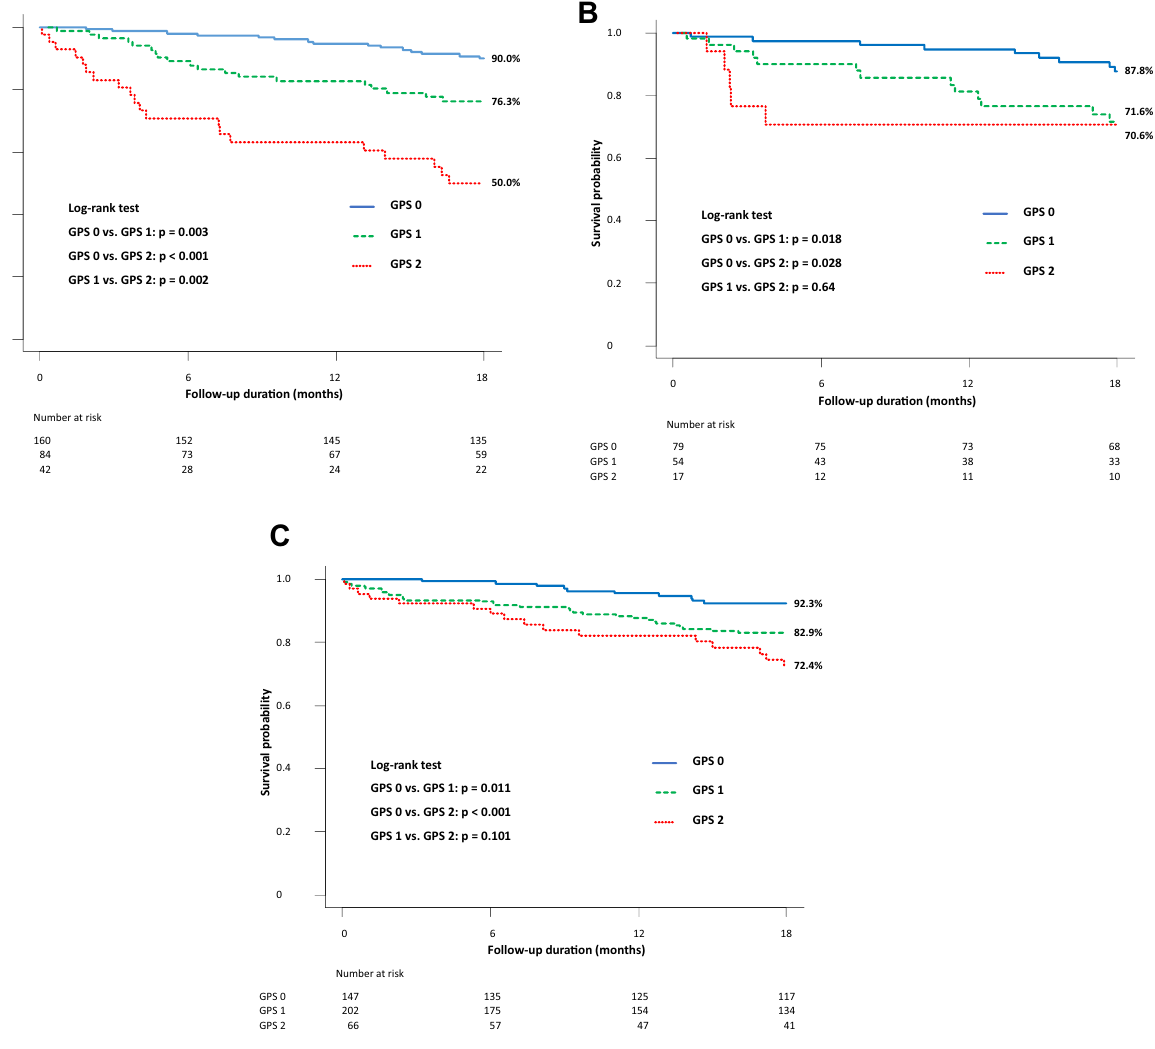
Figure 4. Kaplan–Meier survival curve of patients by HF subtype. ( A ) Survival probability decreased significantly with increasing GPS in HFrEF patients. ( B ) HFmrEF patients with GPS 0 had significantly higher survival probability than did those with GPS 1 or 2. ( C ) Although HFpEF patients with GPS 0 had significantly higher survival probability than did those with GPS 1, no other remarkable differences were seen. GPS Glasgow Prognostic Score, HFmrEF heart failure with mid-range ejection fraction, HFpEF heart failure with preserved ejection fraction, HFrEF heart failure with reduced ejection